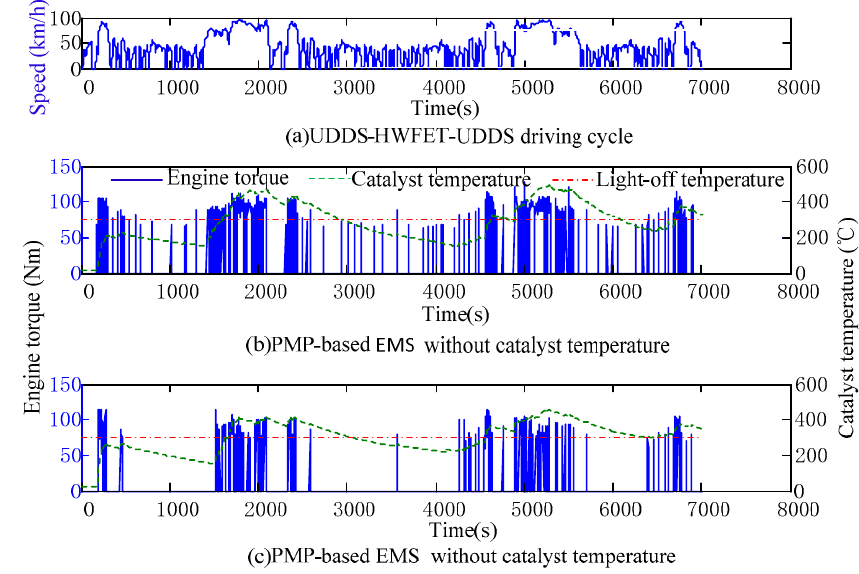
Figure 16. Comparison of simulation results under an urban dynamometer driving schedule/ highway/urban dynamometer driving schedule (UDDS–HWFET–UDDS) cycle for different energy management strategies (EMSs).